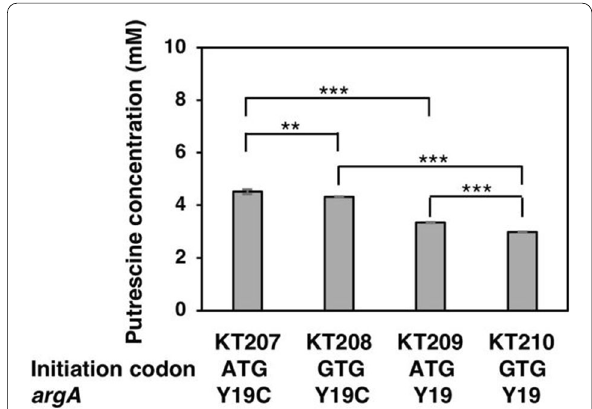
Fig. 2 Base substitution on argA increased putrescine production. Putrescine concentration in the supernatant of strains harboring plasmids with different mutant argA : KT207 ( argA ATG Y19C ), KT208 ( argA GTG Y19C ), KT209 ( argA ATG Y19 ), and KT210 ( argA GTG Y19 ). The strains were grown in LB medium supplemented with 100 μg/mL of ampicillin at 37 °C for 48 h with reciprocal shaking at 120 rpm. When the OD 600 reached 0.4, 0.02 mM IPTG was added. **, p < 0.01; ***, p < 0.001. Data shown are averages standard deviations, and culture ± experiments were performed in triplicate